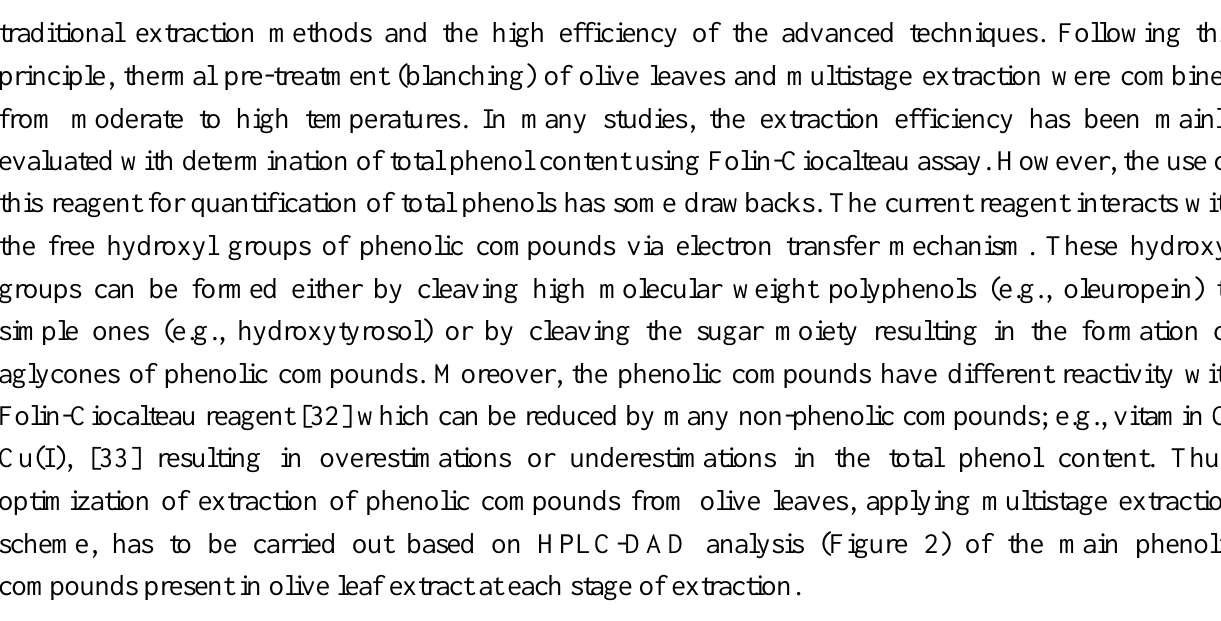
Figure 2. Chromatographic analysis (HPLC-DAD) of ethanolic olive leaf extract at 280 nm. ( a ) first stage; ( b ) second stage; and ( c ) third stage. 1 : luteolin-7- O -glucoside; 2 : verbascoside; 3 : apigenin-7- O -glucoside; and 4 :